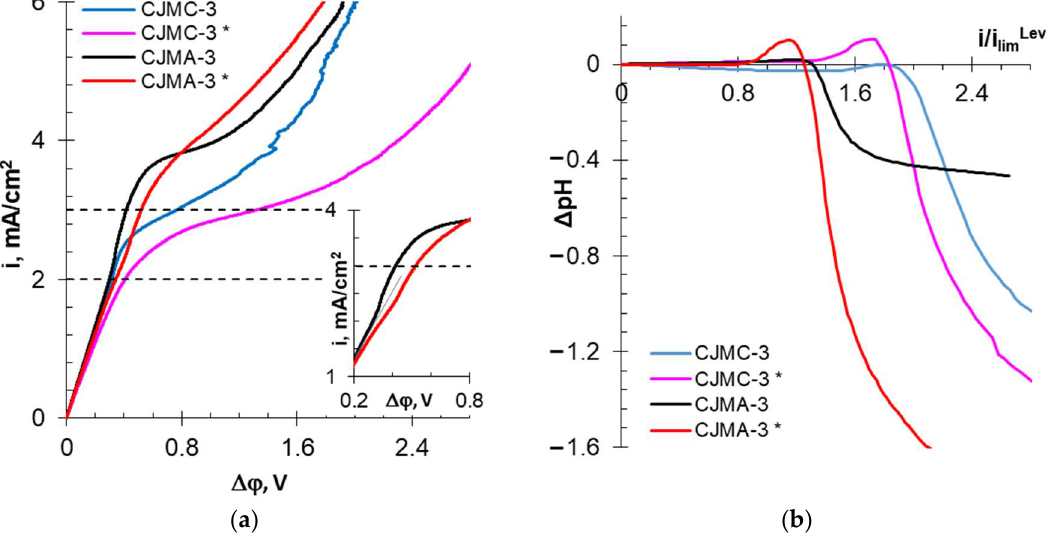
Figure 9. Current–voltage curves ( a ) of aromatic membranes before (CJMC-3 and CJMA-3) and after (CJMC-3 * and CJMA-3 *) electrodialysis processing of the model solution, as well as the dependence of the solution pH difference at the DC output and input upon the current density normalized to the calculated limiting current ( b ). The dependences of ΔpH vs. i/i limLev were obtained in parallel with the CVC measurements. The studies were carried out in 0.02 M NaCl solution. Table 5. Parameters of the current–voltage curves of the studied membranes before and after electrodialysis processing of the model solution.